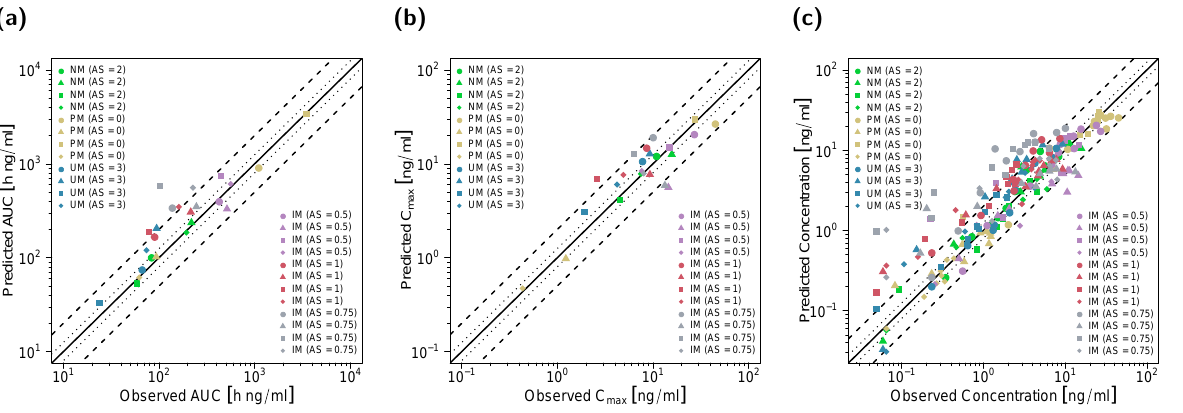
Figure 4. Predicted versus observed AUC last ( a ), C max ( b ) and plasma concentrations ( c ) of ( E )- 1 Clom (circles), ( E )-4-OH-Clom (triangles), ( E )-DE-Clom (squares) and ( E )-4-OH-DE-Clom (dia- monds) in PM, IM, NM and UM (DGI scenarios). The black solid lines mark the lines of identity. Black dotted lines indicate 1.25-fold; black dashed lines indicate two-fold deviation. Goodness- of-fit plots of digitized studies are depicted in Figure S8 of the supplementary document. AS, CYP2D6 activity score; DGI, drug–gene interaction; ( E )-4-OH-Clom, ( E )-4-hydroxyclomiphene; ( E )-4-OH-DE-Clom, ( E )-4-hydroxy-N-desethylclomiphene; ( E )-Clom, ( E )-clomiphene; ( E )-DE-Clom, ( E )-N-desethylclomiphene; IM, intermediate metabolizers; NM, normal metabolizers; PM, poor metabolizers; UM, ultrarapid